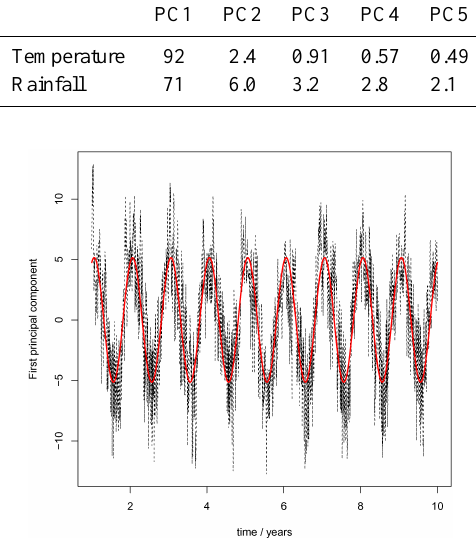
Fig. 8. The first ten years of the first principal component score of the maximum daily temperature. The line (in red) is the fitted value given by the harmonic model (Eq.